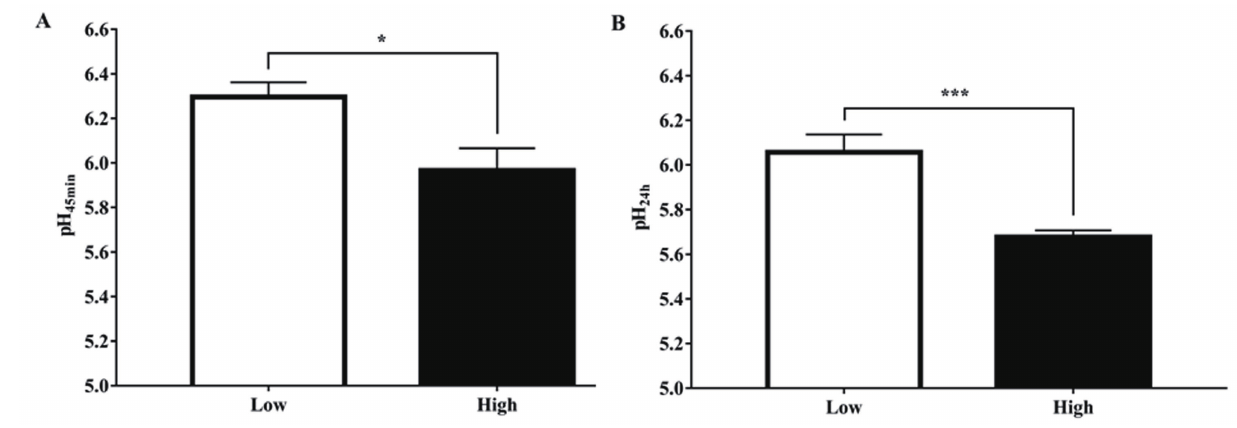
Figure 1. Influence of drip loss on muscle pH at 45 min (A) and 24 h (B) post-mortem in longissimus dorsi muscle of pigs (* p<0.05; *** p<0.001) (n = 10 per group).